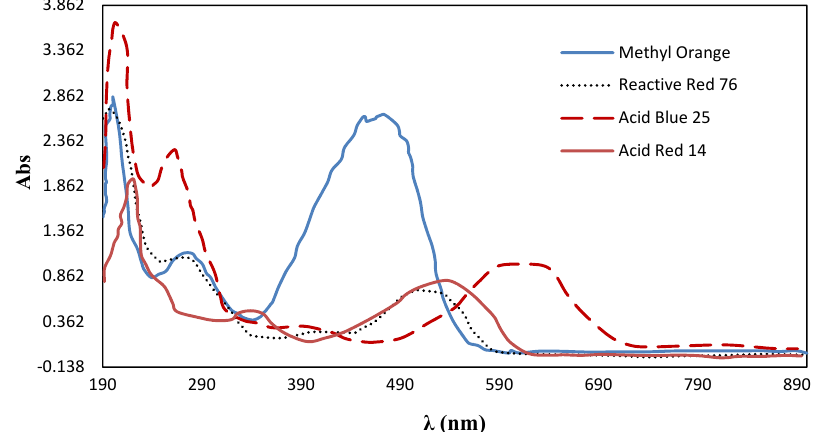
) Nanocomposite dosage = 0.5 g/L, dye concentration = 50 ppm, DO = 7/4 mg/L, pH= 7 (